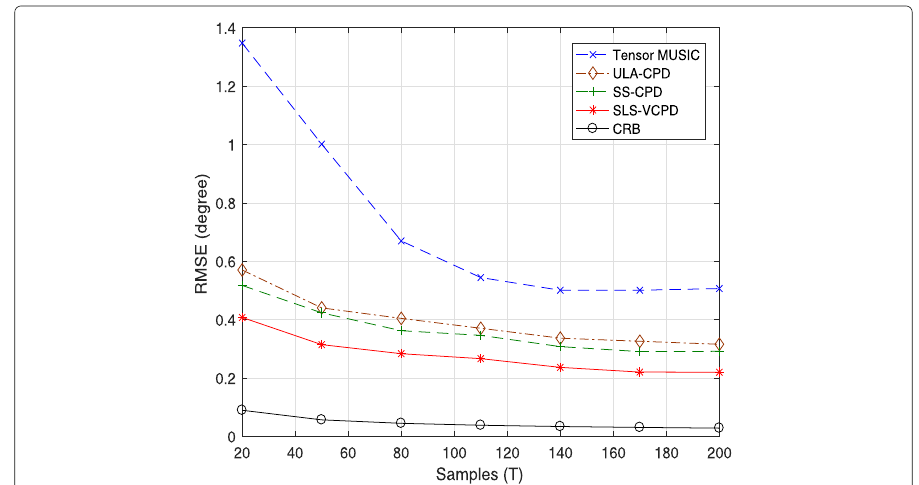
Fig. 9 RMSE versus the number of samples for two sources with M = 6 and SNR=10 dB